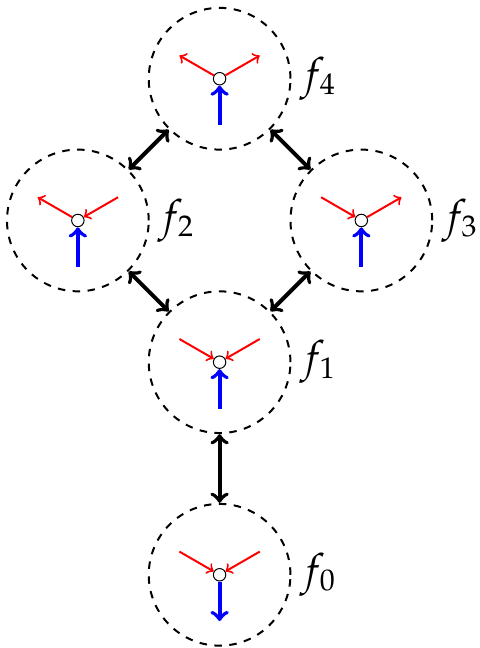
Figure 1. All the possible orientations of edges incident to an AND vertex, where (blue) thick arrows denote the edges with weight 2, and (red) thin arrows denote the edges with weight 1. Each dotted circle represents a possible orientation of the edges, and two circles are joined by an arrow if one is obtained from the other by reversing the direction of a single